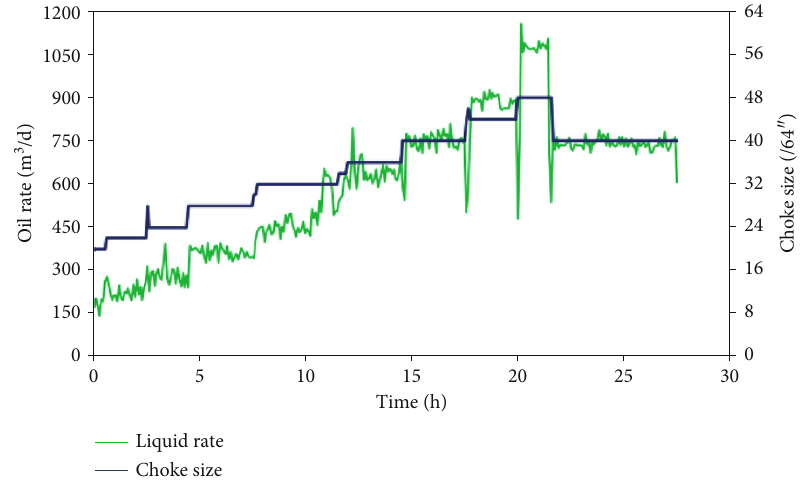
Figure 3: P-4 productivity test curve.